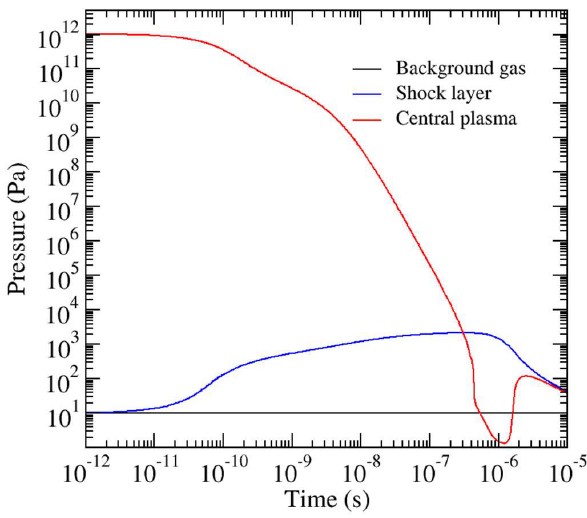
Figure 8. Same as Figure 7, but with an argon pressure of 10 𝑃𝑎 .